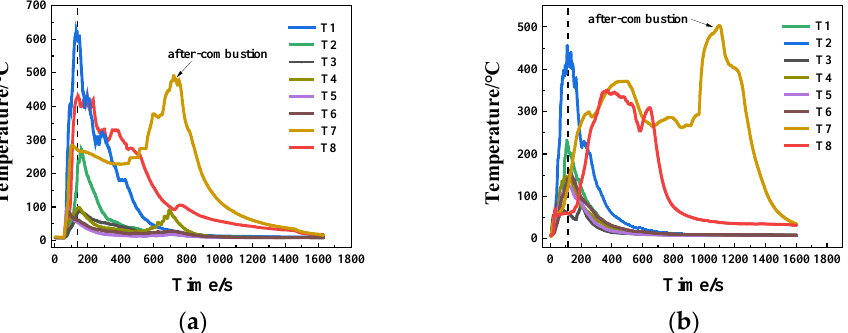
Figure 6. Temperature curve of thermal insulation material under natural combustion state: ( a ) where the materials are placed horizontally, ( b ) where the materials are placed vertically.